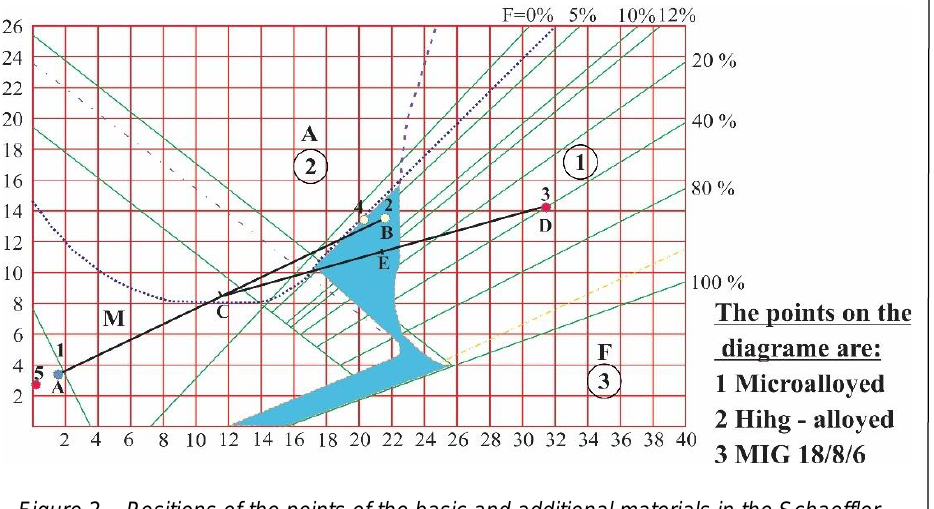
Figure 2 – Positions of the points of the basic and additional materials in the Schaeffler